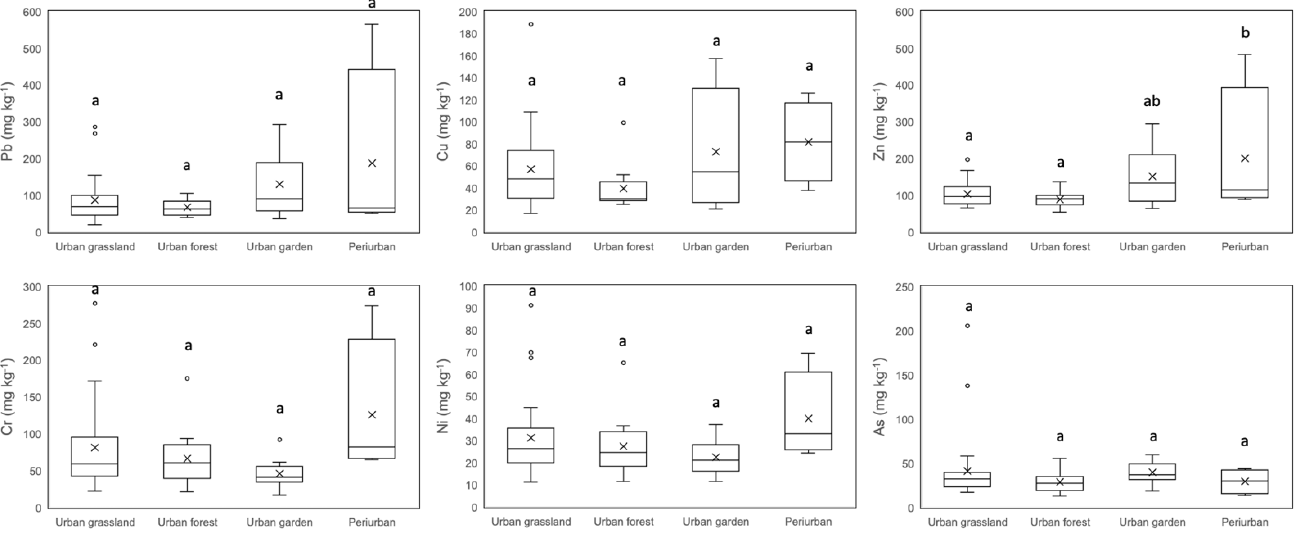
Figure 1. Soil trace element concentrations split by land use. Different letters mean statistically significant differences between land uses in the Tukey test at p < 0.05.